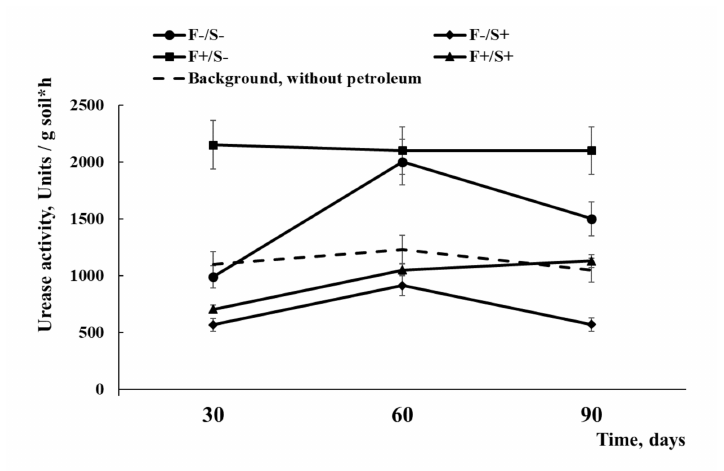
Figure 3. The dynamics of urease activity in bog soil under various options for